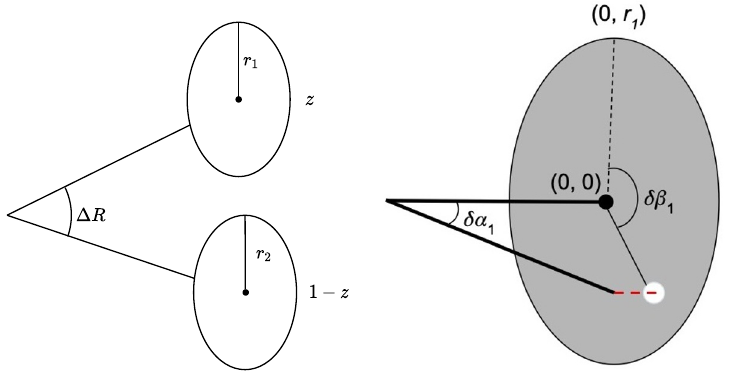
Figure 2. Diagram showing the toy “event” level parameters (left) and the toy “particle” level parameters